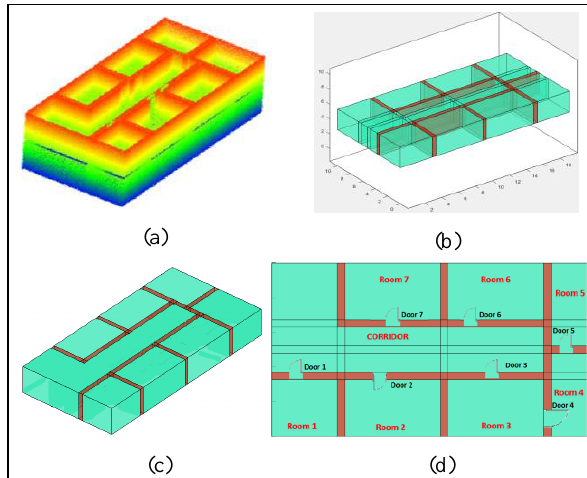
Figure 5. The geometric and semantic reconstruction of the synthetic point cloud of the second floor. (a) the input point cloud; (b) the result of cuboid placement, classification, and merging; (c) the final 3D indoor model; (d) the top-view of the 3D model with space labels and the grid of cuboids. The doors are added manually.